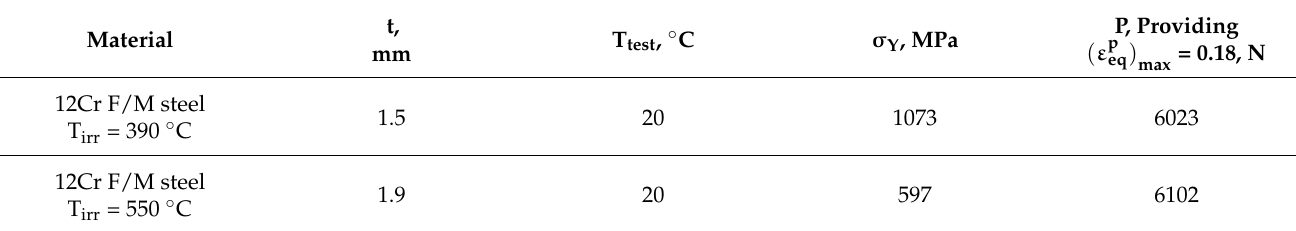
Table 7. Load values providing the required plastic deformation for the opening of corrosion mi- crocracks.